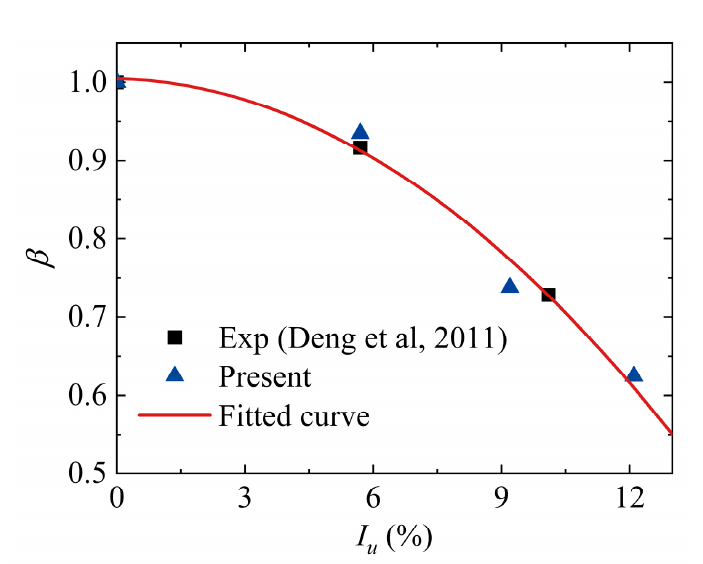
Figure 11. The variation of declined coefficient β versus U * for different I u . ( (cid:4) denotes the experiment conducted by Deng et al. [2]).